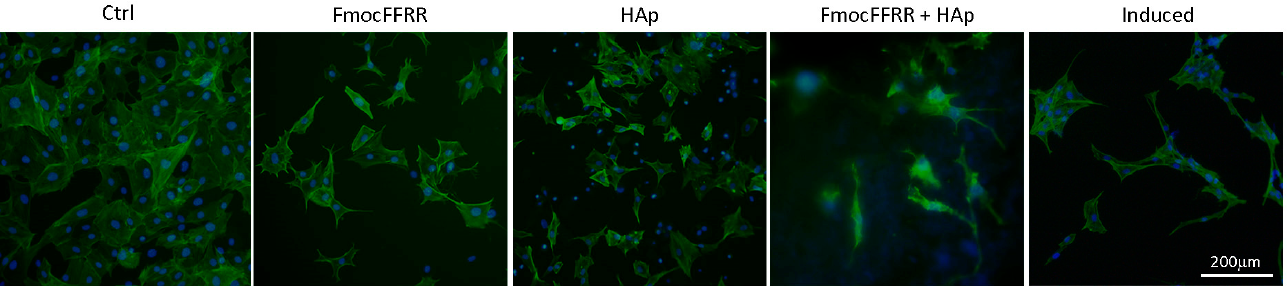
Figure 6. Morphological analysis of MC3T3-E1 cells after culturing in FmocFFRR/HAp (5.0/10.0 mg/mL) hydrogel, free HAp particles (10.0 mg/mL), FmocFFRR assemblies (5.0 mg/mL), or treated with osteoinduction medium (Induced) for 5days. F-actin filaments were stained with Alexa Fluor 488-conjugated phalloidins, and nuclear were stained with DAPI (blue).